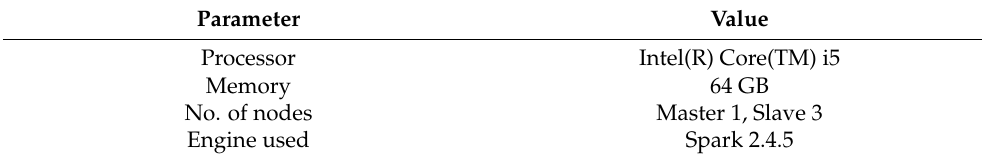
Table 1. Experimental environment.